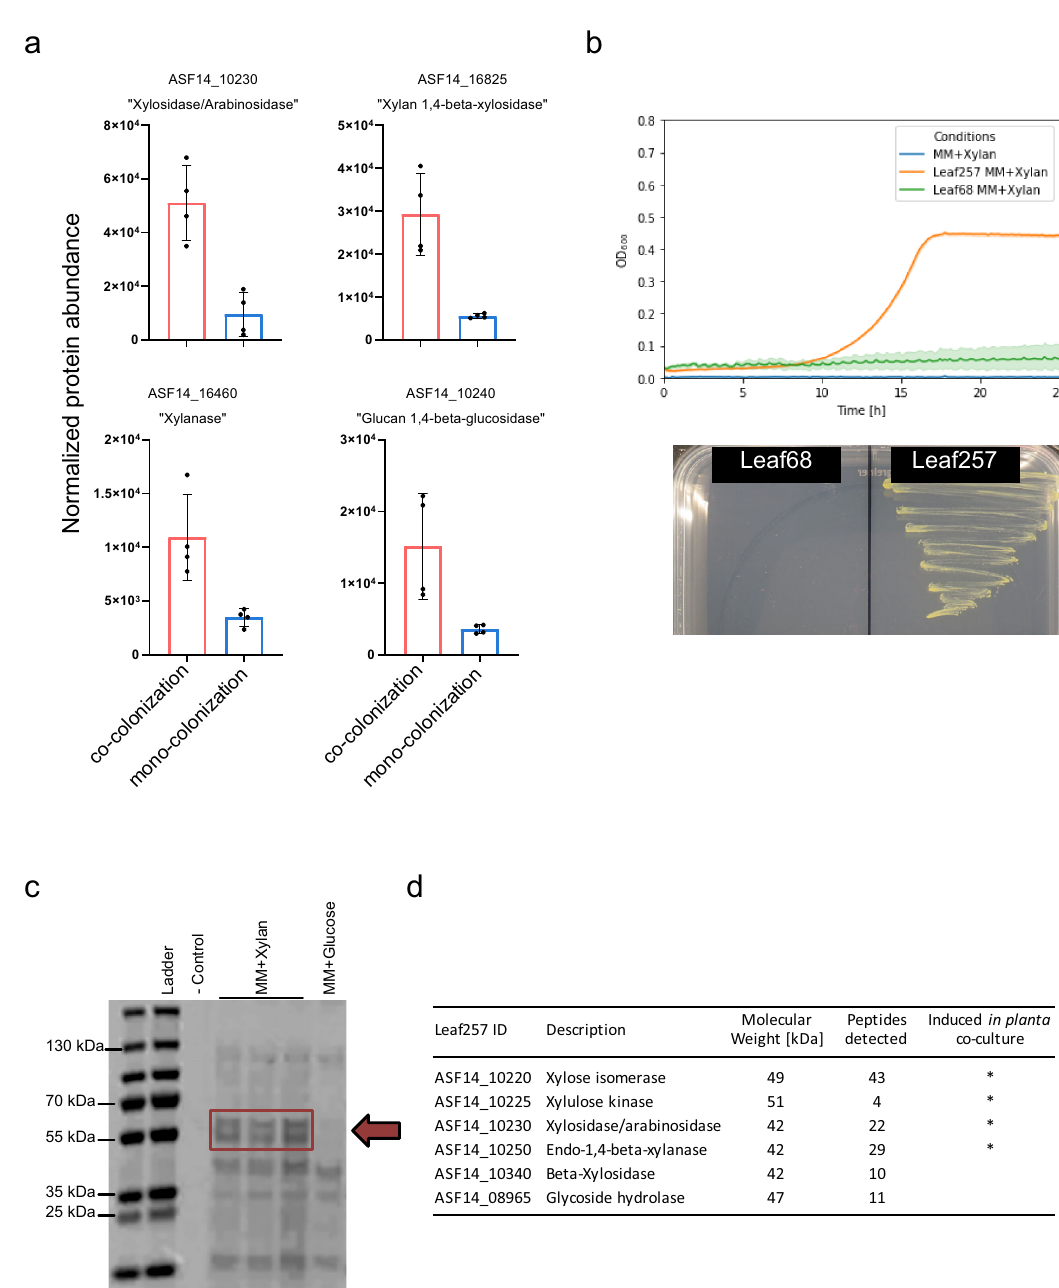
Fig. 3 Sphingomonas Leaf257 utilizes plant-derived xylan. a Normalized abundance of proteins related to xylan degradation obtained from the proteomics work fl ow (see methods, Supplementary Data 4) upon co-colonization (red) and mono-colonization (blue) for four enzymes potentially involved in xylan degradation. Error bars represent the standard deviation. Data are from 4 independent replicates, n = 4). b Growth curve depicting optical density (OD 600 ) of Sphingomonas Leaf257 (orange), Rhizobium Leaf68 (green) and negative control (blue) in minimal medium with 10 mM xylan in liquid (top) and growth on solid minimal medium with 10 mM xylan for Leaf257, Leaf68 (no growth) (bottom). Error bars (top) represent the standard deviation. Data are from 5 independent replicates, n = 5. c SDS-gel of enriched supernatant (see methods) of Sphingomonas Leaf257 grown in liquid minimal medium with ddH 2 O (control), xylan or glucose. For MM + xylan three biological independent replicates were prepared. One replicate was prepared for the control MM + glucose. The xylan speci fi c double-band at ca. 55 kDa (red box) was extracted and analyzed using LC-MS. d Overview of protein identi fi ed in the LC-MS approach. Source data for ( a , b , c ) are provided as a Source data fi compared to arti fi cial media (Fig. 4a, Supplementary Data 2 Rhizobium Leaf68 adapted to phosphate scarcity by engaging and 5). Another observation was that biotin synthase global regulatory mechanisms. One of the most reduced proteins (ASF03_03440), the last enzyme in the biotin biosynthesis, was during co-colonization was alcohol dehydrogenase signi fi cantly reduced in Rhizobium Leaf68 upon co-colonization (ASF03_19755; Log 2 fold-change < − 6.8), which was striking as the enzyme was highly induced in the mono-colonization with Sphingomonas Leaf257.